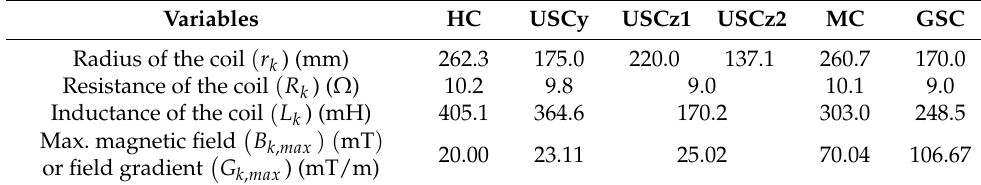
Table 3. Correction coefficients of the MNS.